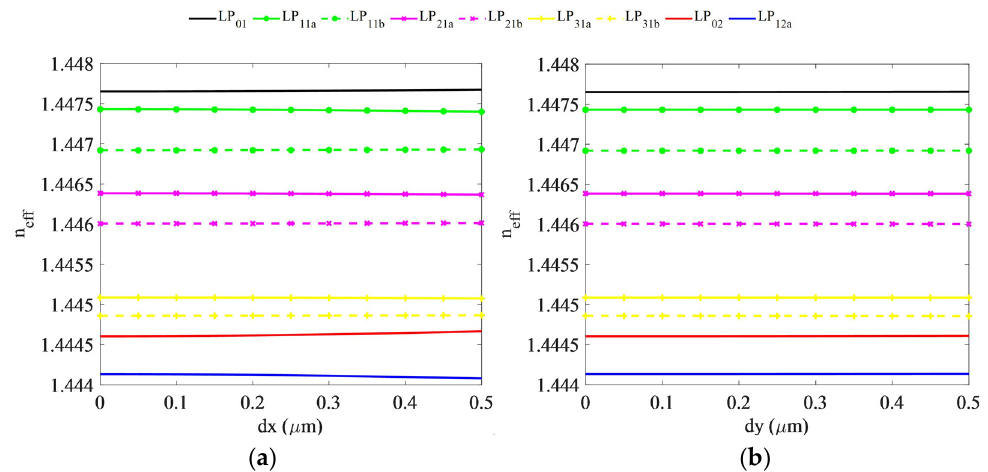
Figure 5. The influence of ( a ) offset in the x -axis direction (dx) and ( b ) offset in the y -axis direction (dy) on effective refractive index (n eff ) for each mode.